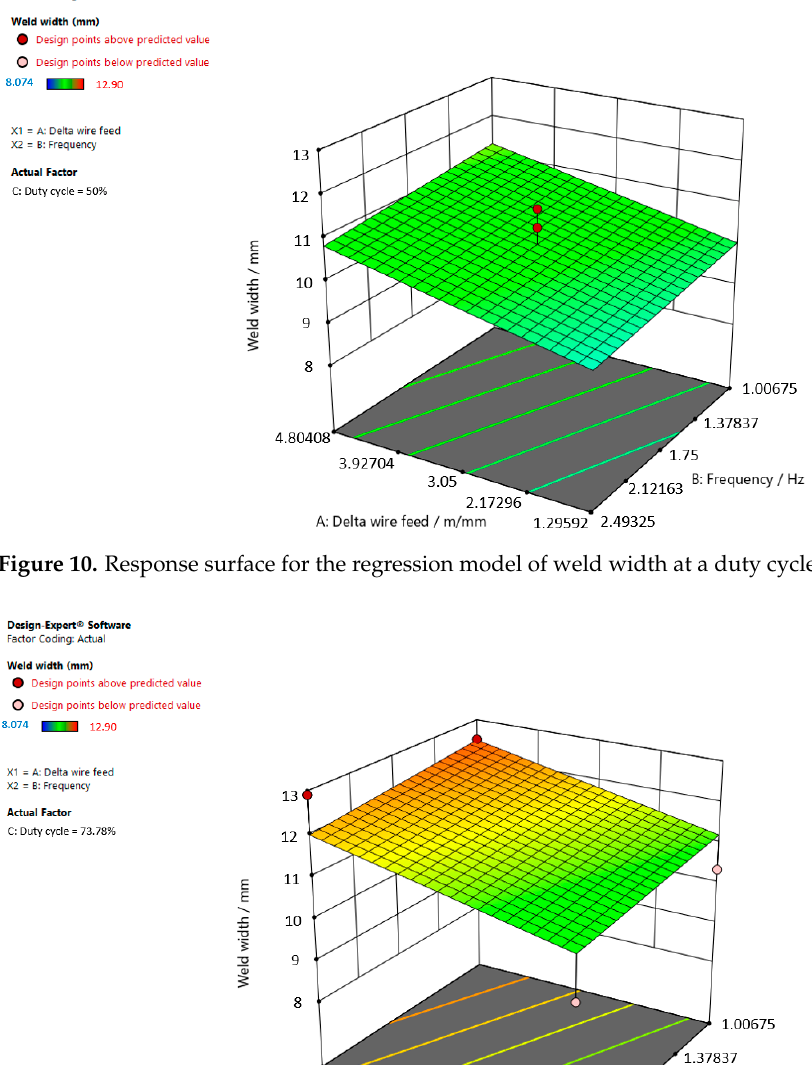
Figure 9. Response surface for the regression model of weld width at a duty cycle of 26.216%.